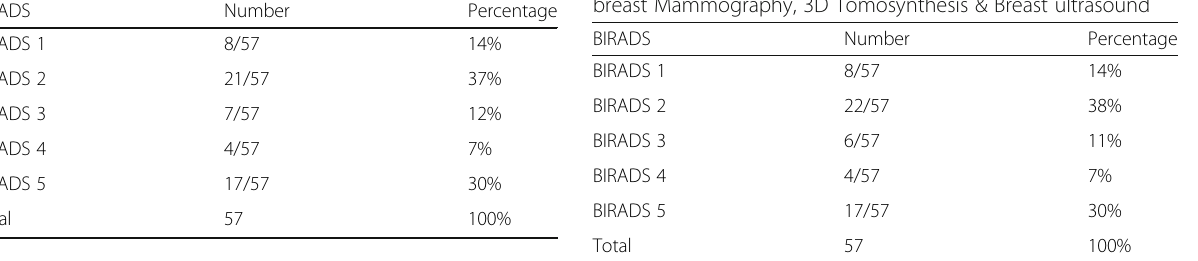
Table 7 showing the BI-RADS categories by combined digital breast Mammography, 3D Tomosynthesis & Breast ultrasound